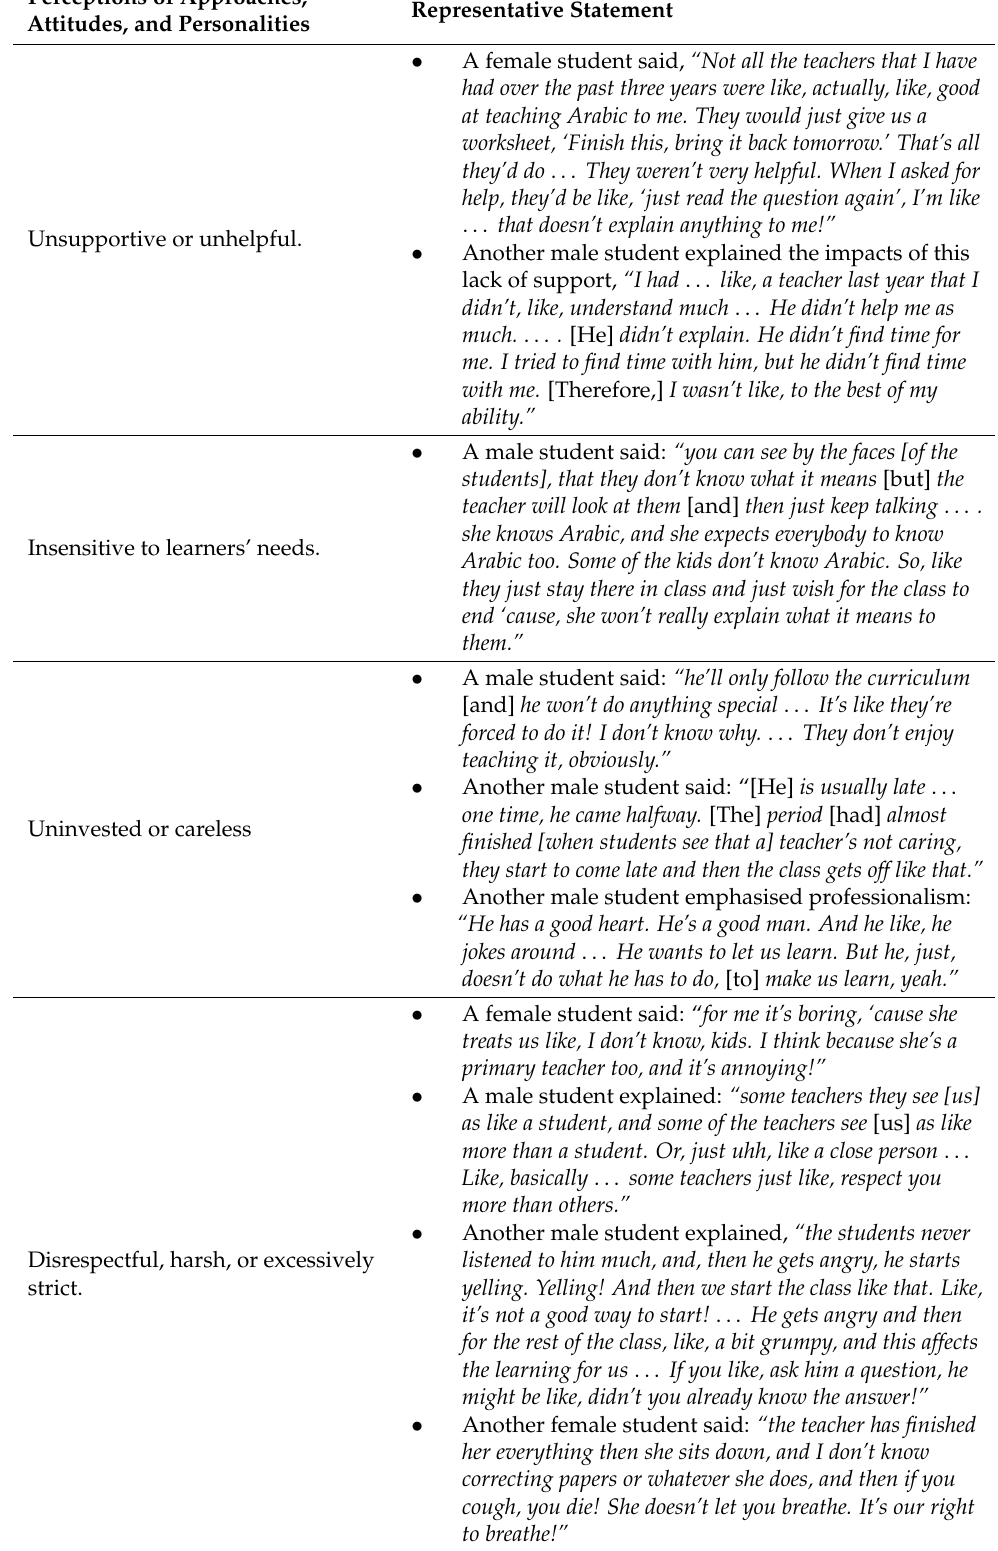
Table 3. Perceptions of teachers’